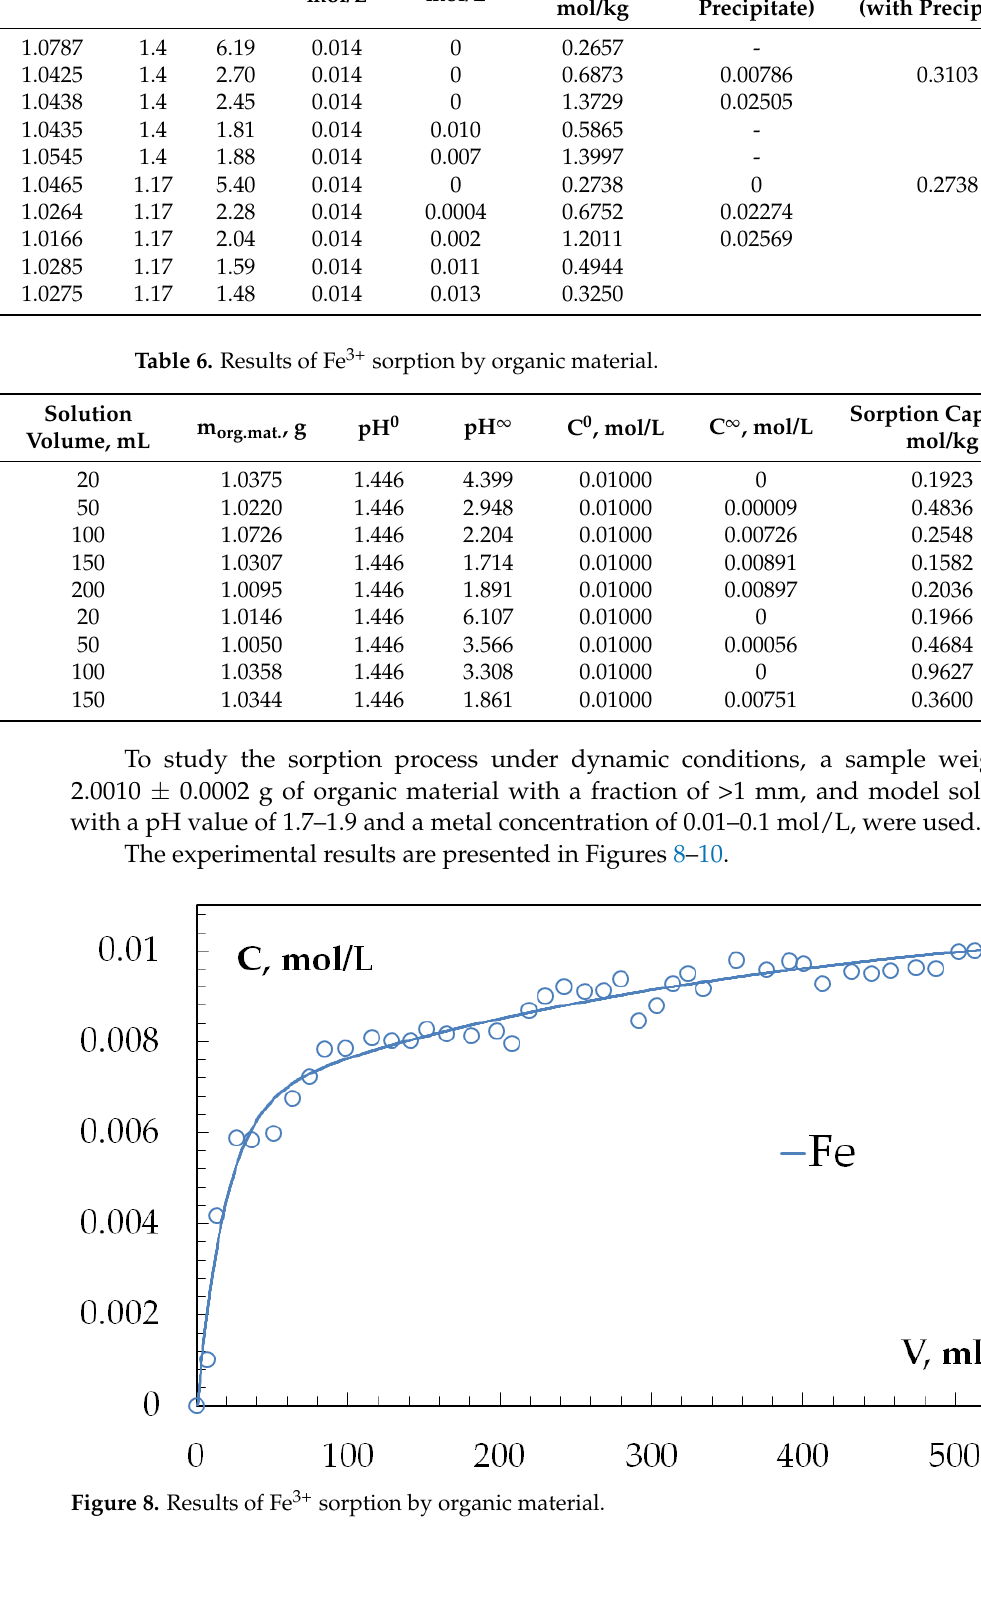
Figure 9. Results of Hg 2+ sorption by organic material.